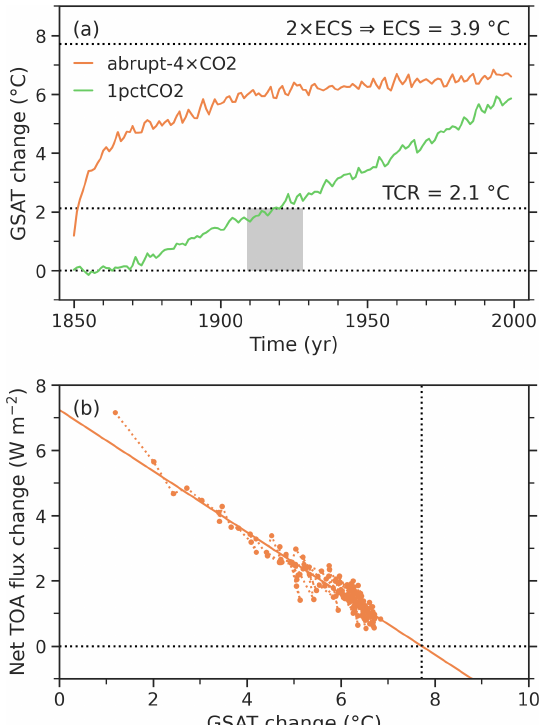
Figure 4. (a) GSAT change in the simulation with abrupt qua- drupling of CO 2 concentrations (abrupt-4 × CO2) and the simula- tion with a 1% CO 2 concentration increase per year (1pctCO2). (b) Global net radiative flux change at the top of the atmosphere versus GSAT change in the abrupt-4 × CO2 experiment, along with a linear fit obtained by Theil–Sen regression. The temperature and flux changes shown in this figure are the annual mean deviations from the linear trend lines through the corresponding 150 years of the preindustrial control simulation.